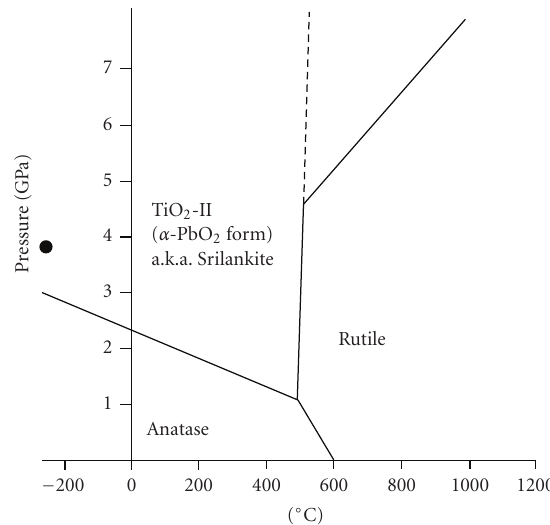
Figure 1: Composite phase diagram for TiO 2 . The anatase/TiO 2 - II, anatase/rutile, and TiO 2 -II/rutile phase boundaries are taken from Ren et al. [71]. The TiO 2 -II/rutile phase boundary at high temperatures and pressures is taken from Withers et al. [58]. The filled point shows the 0K anatase-to-brookite transition pressure estimated by Beltr´an et al.